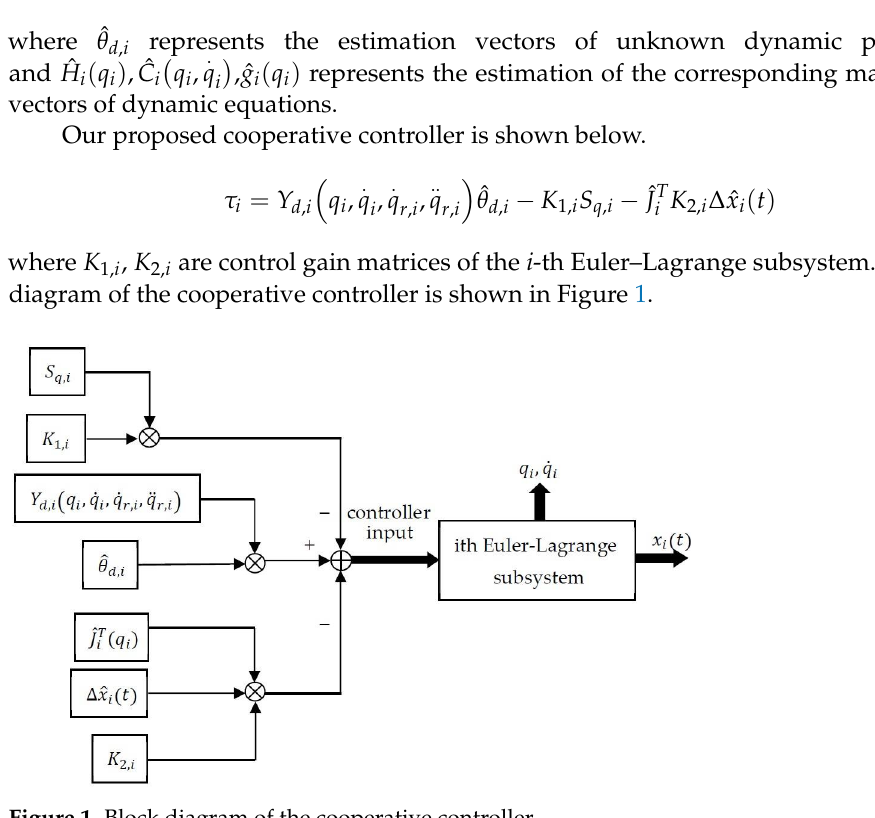
Figure 1. Block diagram of the cooperative controller.